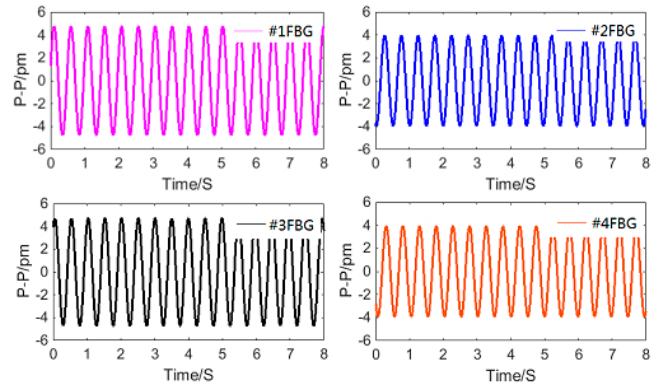
Figure 10. Time domain signal of each FBG under the excitation with acceleration amplitude of 20 m/s 2 and frequency of 2 Hz.